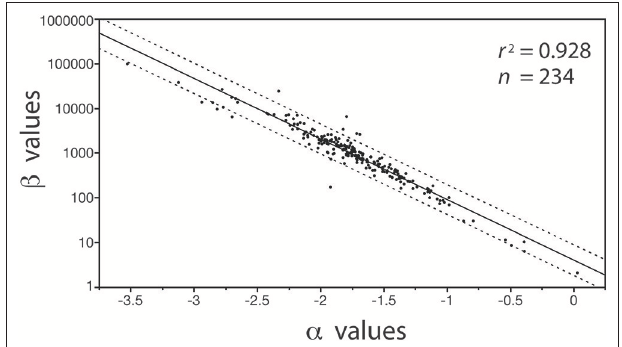
FIGURE 1 | Bivariate plot (and regression statistics of the log-log normal curve) of the inverse autocorrelation between β vs. α values for the regressions of log 10 -transformed stem diameter frequency distributions taking the general form of N { i , j } = β j log D { i , j } α j , where N is the number of stems in a bin size i and D is the diameter of the stems in the size bin i (see Niklas et al., 2003a). Dashed lines denote 95% CIs. The autocorrelation emerges because the measurement units of stem diameter is much smaller than the organisms being measured, i.e., the autocorrelation has no intrinsic biological